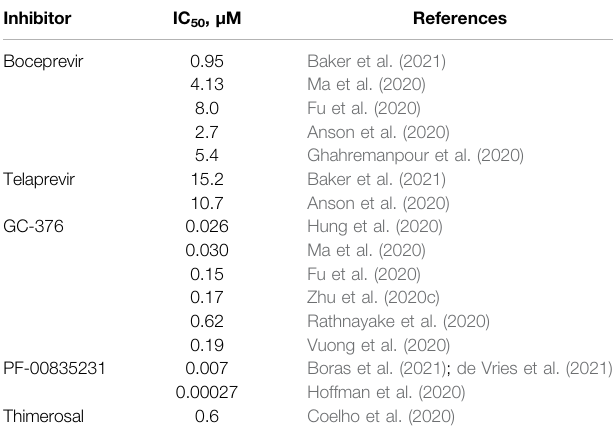
TABLE 1 | M pro 50% inhibitory concentration (IC 50 ) for selected inhibitors. Inhibitor IC 50 , μ